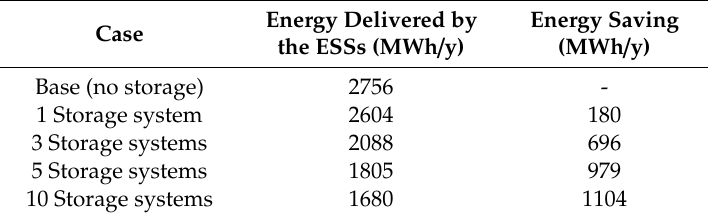
Table 7. ESSs energy demand for traction and related energy saving, for di ff erent storage systems